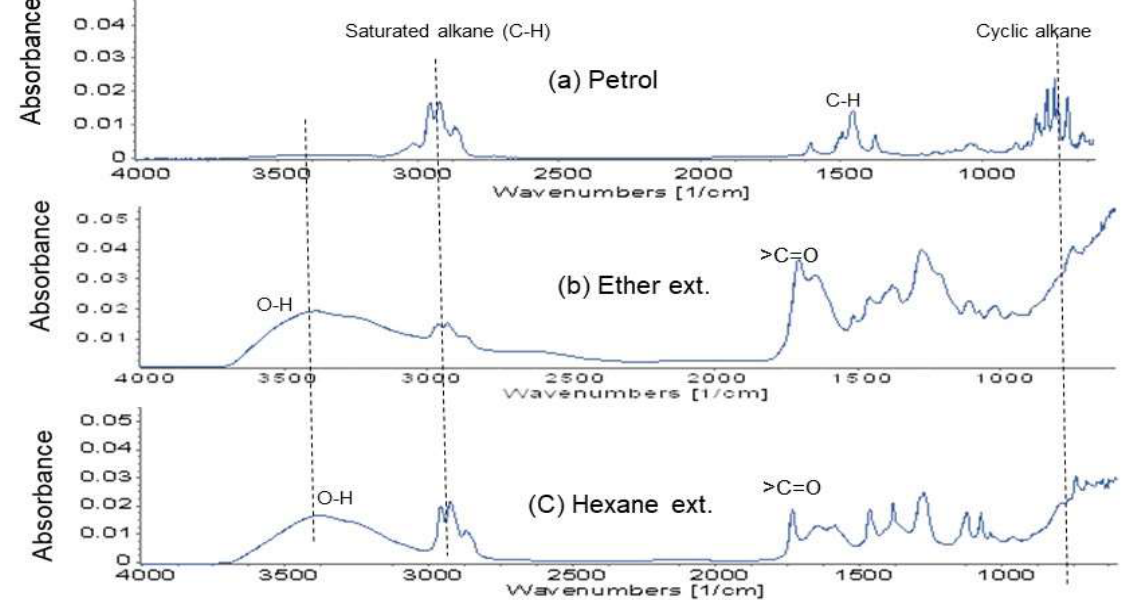
Figure 8. Comparative FTIR micrographs of ( a ) petrol, along with ( b ) ether, and ( c ) hexane extracts (ext.) from HTC-PL. (ext.) from